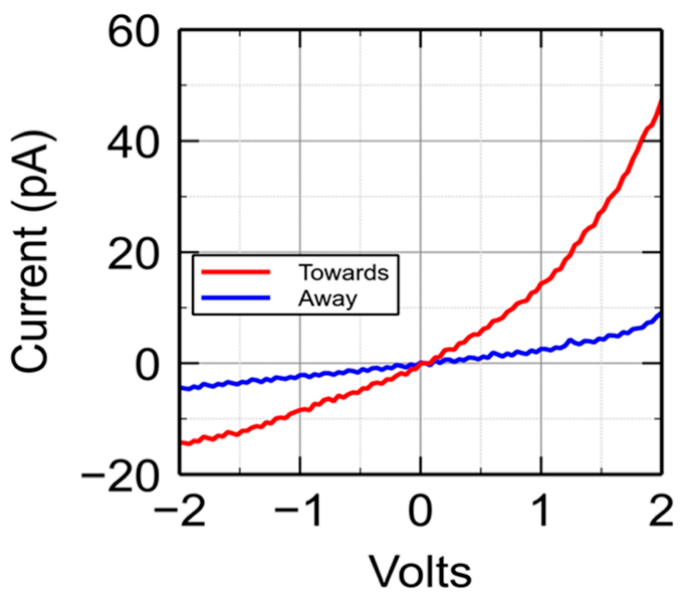
Figure 4. The conductance change seen in a [Fe{H 2 B(pz) 2 } 2 (bipy)], where py = tris(pyrazole-1-y1)- borohydride and bipy = 2,2 ′ -bipyridine), with the reversal of the ferroelectric polarization in an adjacent ferroelectric polyvinylidene fluoride hexafluoropropylene (PVDF-HFP) layer, as described in [14], either toward or away from the molecular spin crossover [Fe{H 2 B(pz) 2 } 2 (bipy)].